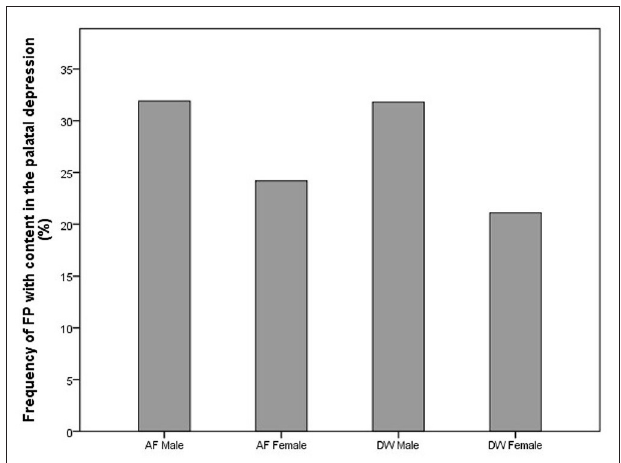
FIGURE 5 | Bar chart showing the frequency (%) of content found in the palatal depressions with FP in the cheetahs of two different facilities (AF, AfriCat; DW, The Ann van Dyk Cheetah Centre).